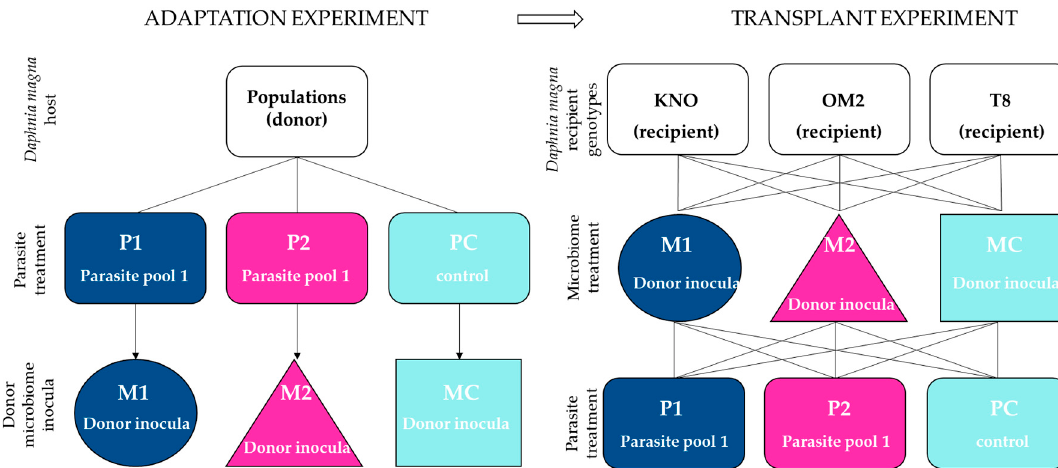
Figure 1. Schematic representation of the experimental design. In the microbial adaptation experiment ( left panel ), all donor populations received a parasite treatment (P1, P2, PC), after which the donor microbial inocula were obtained (M1, M2, MC) for the transplant experiment ( right panel ). P1 consisted of a pool of White Fat Cell Disease (WFCD) and Binucleata daphniae. P2 consisted of a pool of Pasteuria ramosa, Ordospora colligata and Mitosporidium daphniae. PC is the control treatment and consisted of a pool of healthy squashed Daphnia individuals. In the transplant experiment ( right panel ), sterile recipient individuals of three Daphnia genotypes (KNO, OM2, T8) were exposed to the donor microbiomes obtained from the adaptation experiment (M1, M2, or MC). Each of these microbiome treatments were crossed with the three parasite treatments (P1, P2, or PC; similar as in the microbiome adaptation experiment).